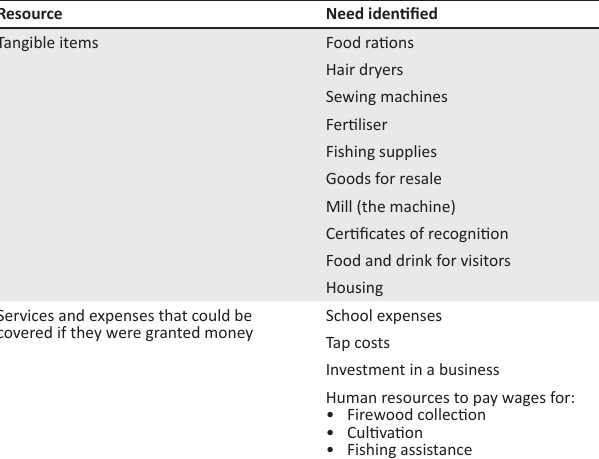
TABLE 3: Material resources that participants stated they did not have and/or needed.